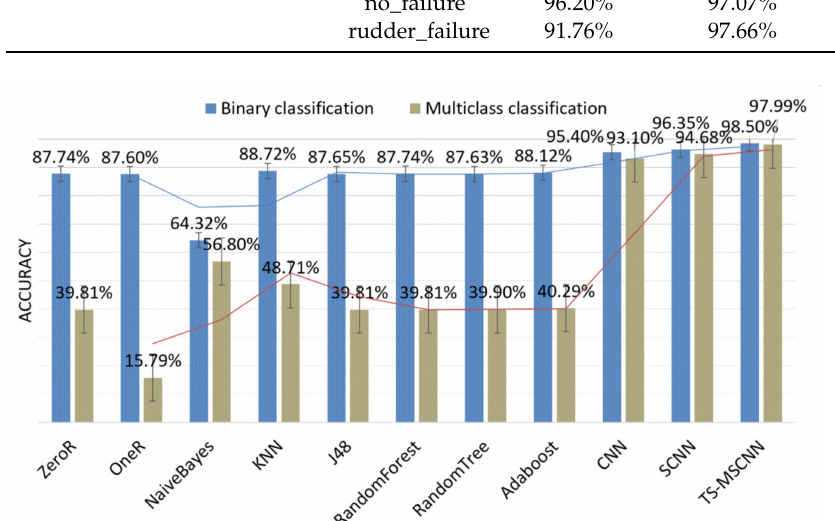
Figure 16. Comparison between the binary classification and the multiclass classification.